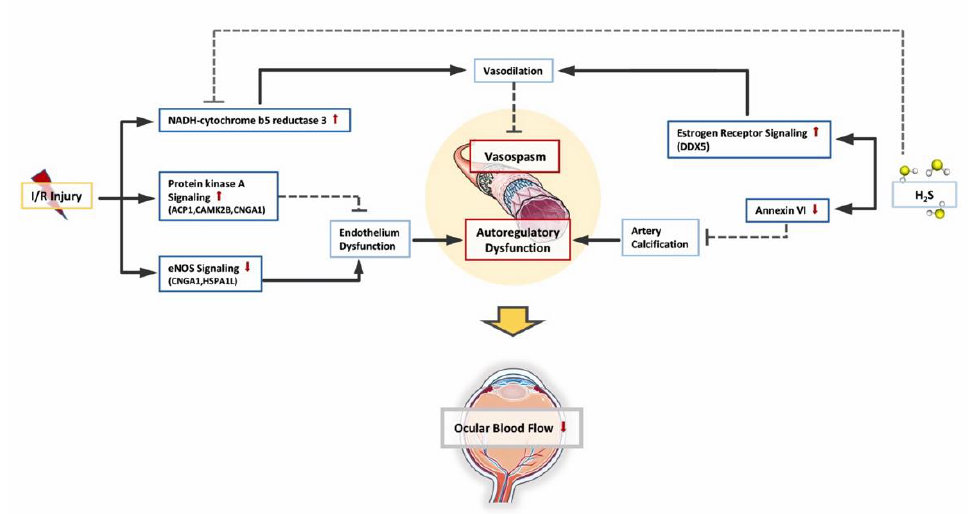
Figure 7. Changes in retinal vascular function. Due to I / R, PKA (protein kinase A) signaling and NADH-cytochrome b5 reductase 3( Cyb5r3 ) is upregulated as self-protective mechanism to maintain endothelial function and vasodilation, while eNOS signaling is downregulated as an indication of endothelial dysfunction. Administration of H 2 S activated estrogen receptor signaling to facilitate vascular relaxation. H 2 S also reduced the abundance of annexin A6, which plays a central role in artery calcification. Combined together, H 2 S protected the blood flow regulatory mechanisms and enabled a less constricted vascular environment in retina against I / R injury.